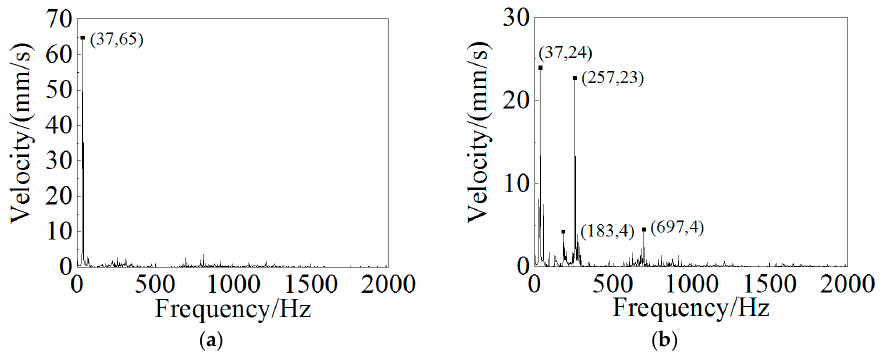
Figure 24. Frequency responses of ( a ) the isotropic and ( b ) the orthotropic oil cooler covers at Point 4 of Figure 20.